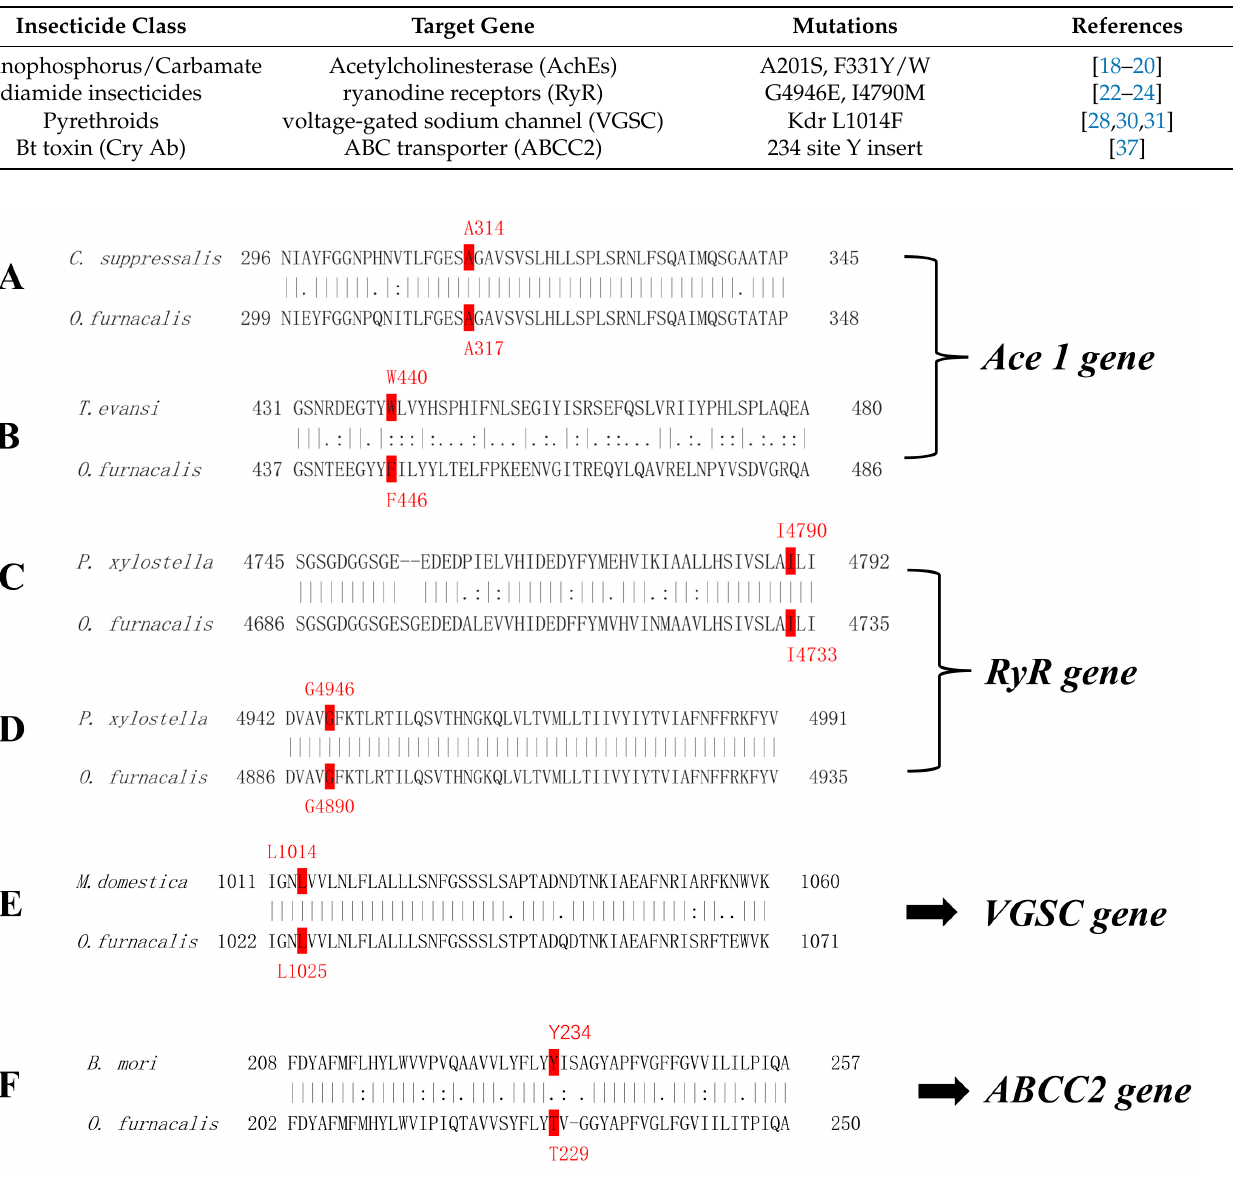
Table 2. The basic information of mutations examined in the present study.